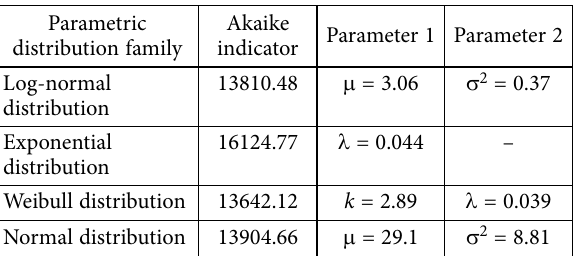
Table 2. Values of the Akaike information criterion for selected